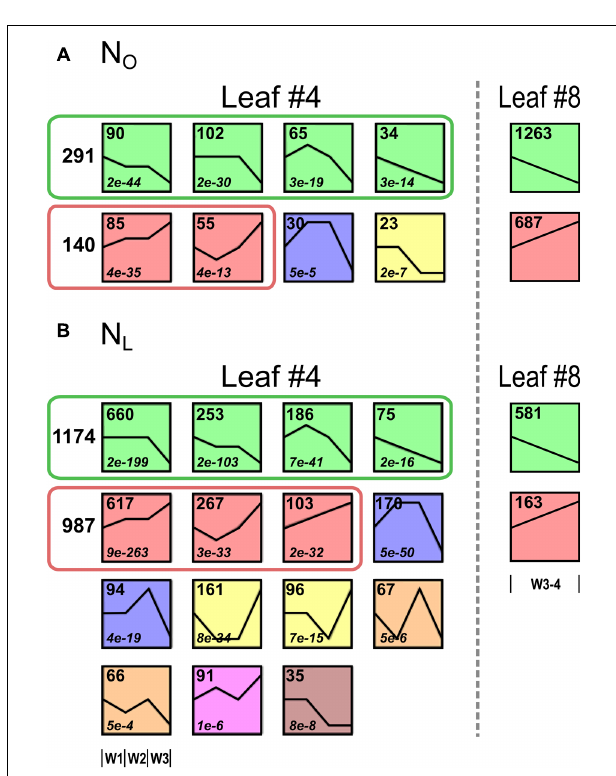
FIGURE 3 | Clustering of regulated genes with similar temporal expression profiles in leaf #4. The leaf #4 genes regulated during development under optimal and reduced N supply were clustered according to their temporal expression profiles. The mean expression values (log2) of all differentially regulated genes ( ≥ 3-fold expression change in W1, W2, or W3 and P adj < 0.05) were grouped by STEM using default settings. Each box represents one of 50 predefined expression profiles. Depicted are only profiles with a statistically significant number of genes assigned. Profiles with the same color are similar and defined as one cluster. The number of genes belonging to each model expression profile is shown in the top left corner of each box. (A) Of the 655 regulated genes under optimal N supply (N O ), 484 genes are allocated to four clusters. Two hundred and ninety one genes are allocated to one ‘downregulated’ cluster that is subdivided in four profiles (green boxes) and 140 genes are allocated to one ‘upregulated’ cluster subdivided in two profiles (red boxes). To the right the numbers of up- and downregulated N O leaf #8 genes are shown. (B) Of the 3111 regulated genes under reduced N supply (N L ), 2771 genes are allocated to seven clusters. 1174 genes are allocated to one ‘downregulated’ cluster that is subdivided in four profiles (green boxes) and 987 genes are allocated to one ‘upregulated’ cluster subdivided in three profiles (red boxes). To the right the numbers of up- and downregulated N O leaf #8 genes are shown.